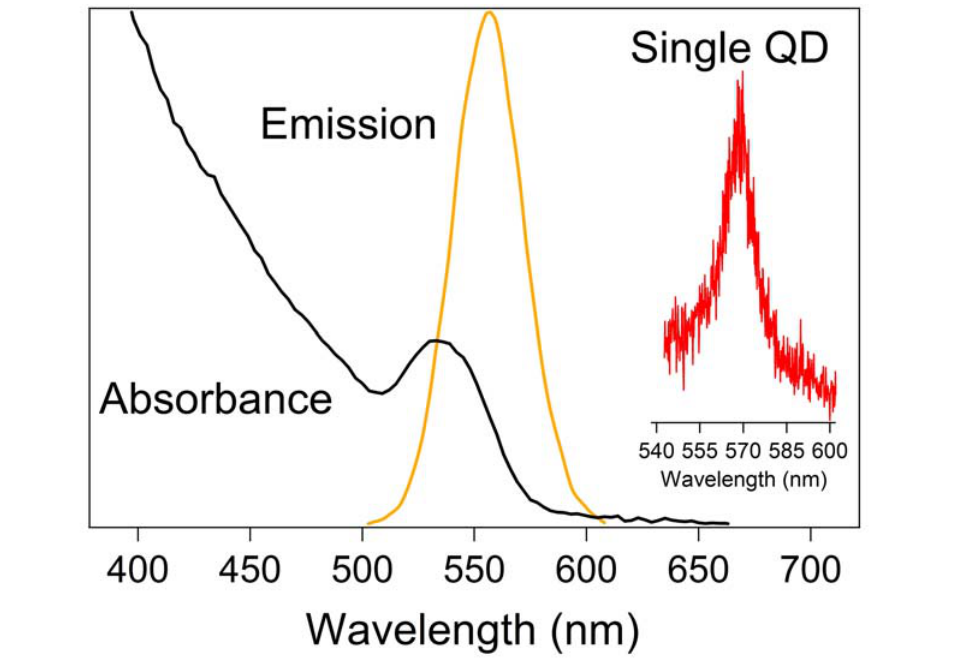
= 350 nm) curves for water soluble CdSe quantum Figure 2. Absorbance and emission ( λ ex dots. The inset shows the emission spectrum from a single quantum dot excited with the 457 nm line of an Ar +